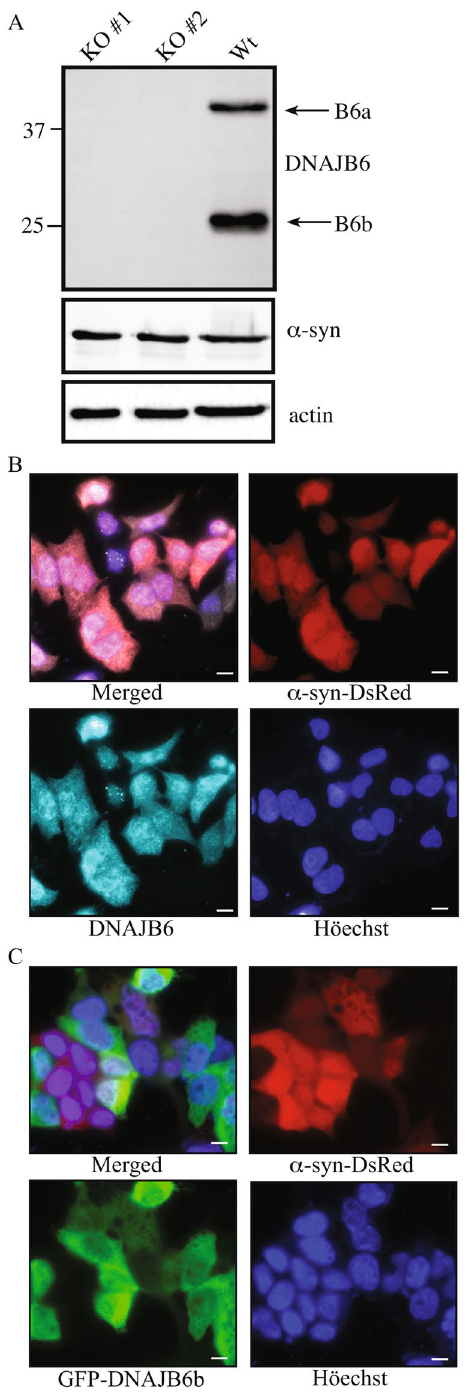
Figure 1. Expression and KO of DNAJB6 in HEK293T- α -syn-DsRed cells. ( A ) Western blot depicting KO of DNAJB6 expression in α -syn-DsRed HEK293T clone 1 and 2, as analyzed by probing the membrane with anti- DNAJB6 and anti- α -syn antibodies, respectively, as well as RDye fluorescently labeled secondary antibodies. ( B ) Immunocytochemistry showing expression of the endogenous DNAJB6a and DNAJB6b forms in α -syn- DsRed HEK293T cells. Cells were stained with 1 st anti-DNAJB6 and 2 nd anti-rabbit dylight 649 antibodies. ( c ) Flourescence microscopy displaying expression and localization of GFP-DNAJB6 in transfected HEK293T- α - syn-DsRed cells. Scalebar: 10 μ